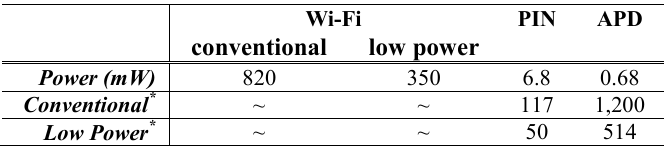
Figure 3 the angular misalignment α of the PD on (a) Laptop and (b) Tablet